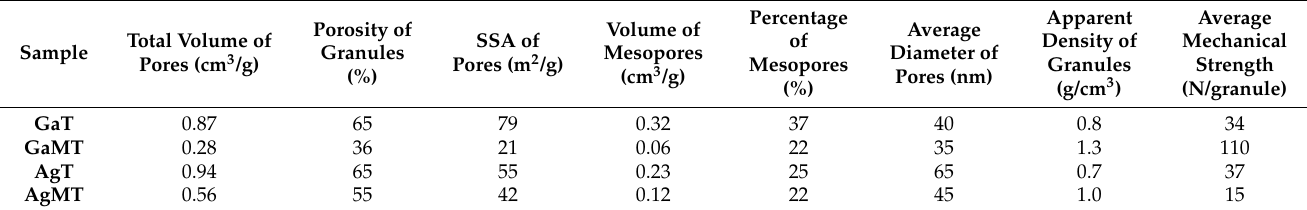
Table 2. Results of porosity and mechanical strength